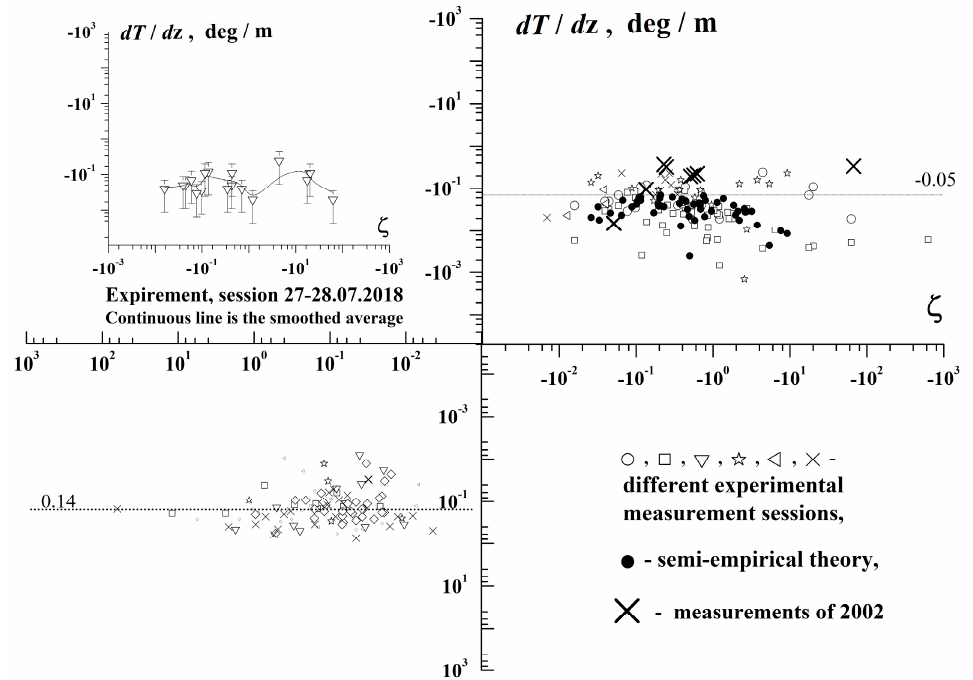
Figure 7. Comparison experimental (various light symbols for different sessions of measurements) and theoretical values (black circles, the semi-empirical theory) of the vertical derivative of the average air temperature of dT / dz in a mountain boundary layer. Sessions of measurements: ○ —27–28.07.18, □ —28.07.18, ▽ —28.07.18, ☆ —28–29.07.18, ◁ —29–30.07.18, ×—30.07–01.08.18. In the insert, the measurement session on 27 and 28 July 2018 with confidential intervals for experimental points is shown above on the left. × is the data of measurements from [10,11].